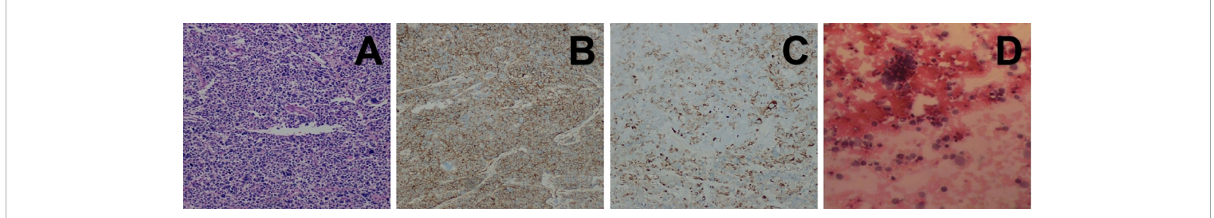
FIGURE 2 (A) Histopathological image showing tumor cells composed of primitive small round cells (H&E staining). (B, C) Immunohistochemical images showing positivity for CD99 and desmin. (D) Histopathological image showing pericardial effusion, which consisted of poor differentiation of malignant